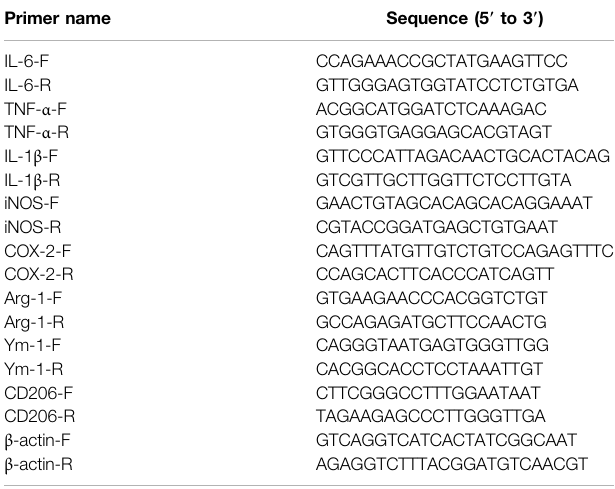
TABLE 1 | Primer sequences for reverse transcription-quantitative polymerase chain